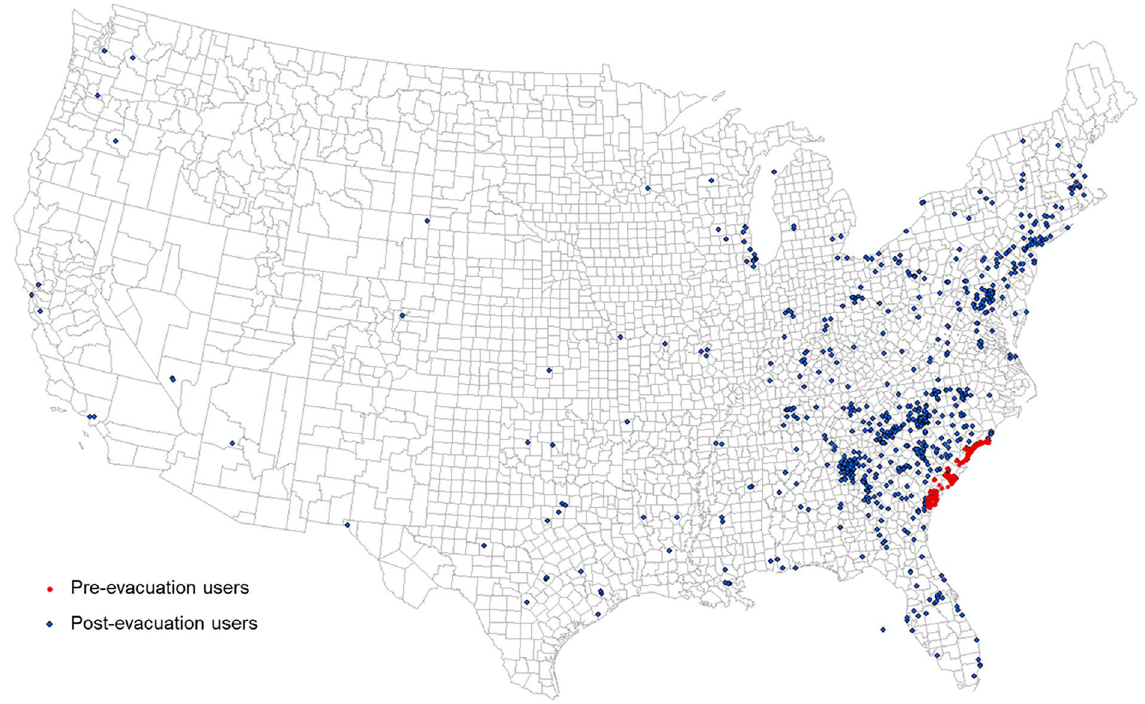
Figure 15. Hurricane Matthew evacuation estimation using geotagged Tweets. Red dots indicate user locations during the pre-evacuation period (October 2–4, 2016). Blue dots show user locations during the post- evacuation period (October 7–9, 2016). The map was generated using ArcMap version 10.7.1.